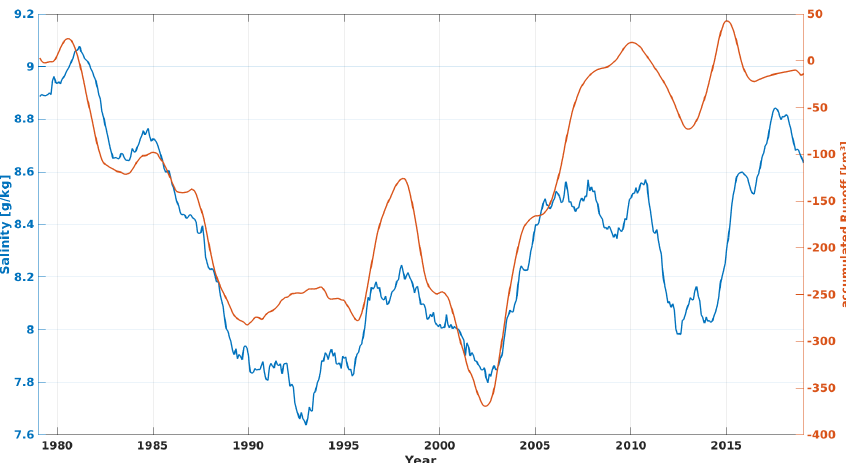
Figure 5. Volume-averaged salinity of Subdivision 28 (SD 28, eastern Gotland Basin) for the period 1979 to 2018 and accumulated anomalies of runoff to the Baltic Sea (inverted). The correlation coefficient is 0.75. All series are 12-month running means. Runoff data from http: //helcom.fi/baltic-sea-trends/environment-fact-sheets (last access: 14 February